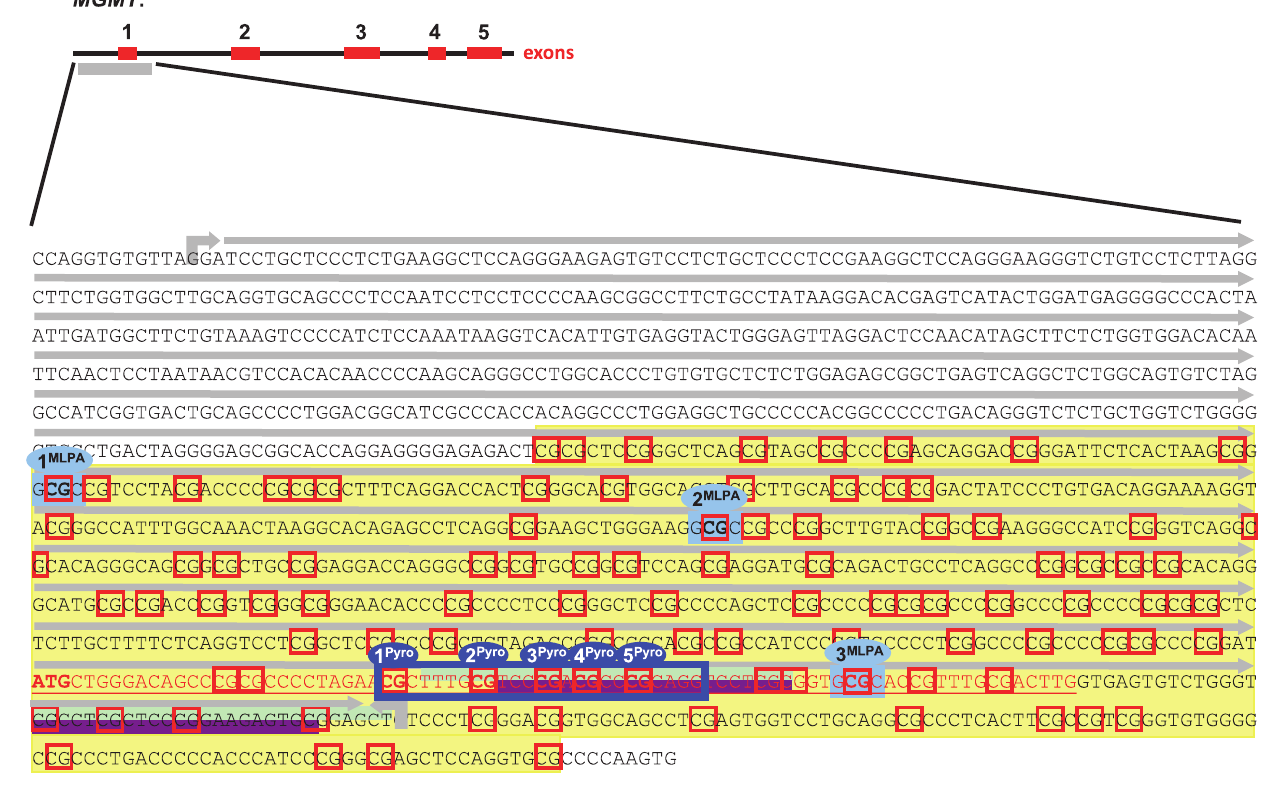
Figure 1. Schematic overview of the MGMT promoter region including CpG sites interrogated by each diagnostic method. Grey arrow, MGMT promoter region; filled yellow box, complete CpG island; red boxes, single CpG sites; understriked red labelled sequence, MGMT exon 1 with start codon marked in bold type; purple bars, methylation-specific (M) primers for MSP according to [2]; mint bars, unmethylation-specific (U) primers for MSP according to [2]; dark blue box, PSQ region comprising five CpG sites; light blue boxes, three GCGC Hha l sites for MS-MLPA.